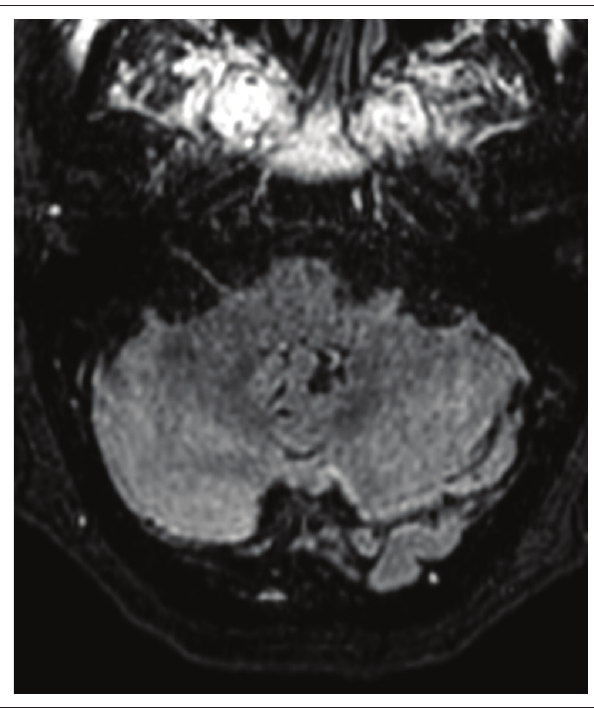
FIGURE 3: Fluid attenuated inversion recovery imaging at the 7-week follow-up imaging, demonstrating resolution of the previous dentate nuclei high signal; compare with Figure 1.